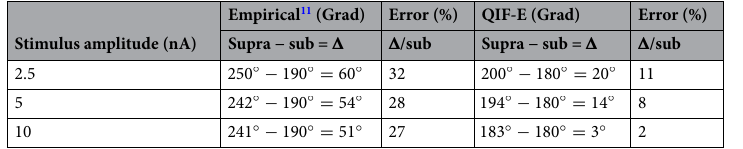
Table 4. Results of suprathreshold empirical population vector phases, and population vector phases obtained by the QIF-E model. The last column contains the relative errors. Model data corresponds to the configuration: frequency of 1 Hz and noise of 10